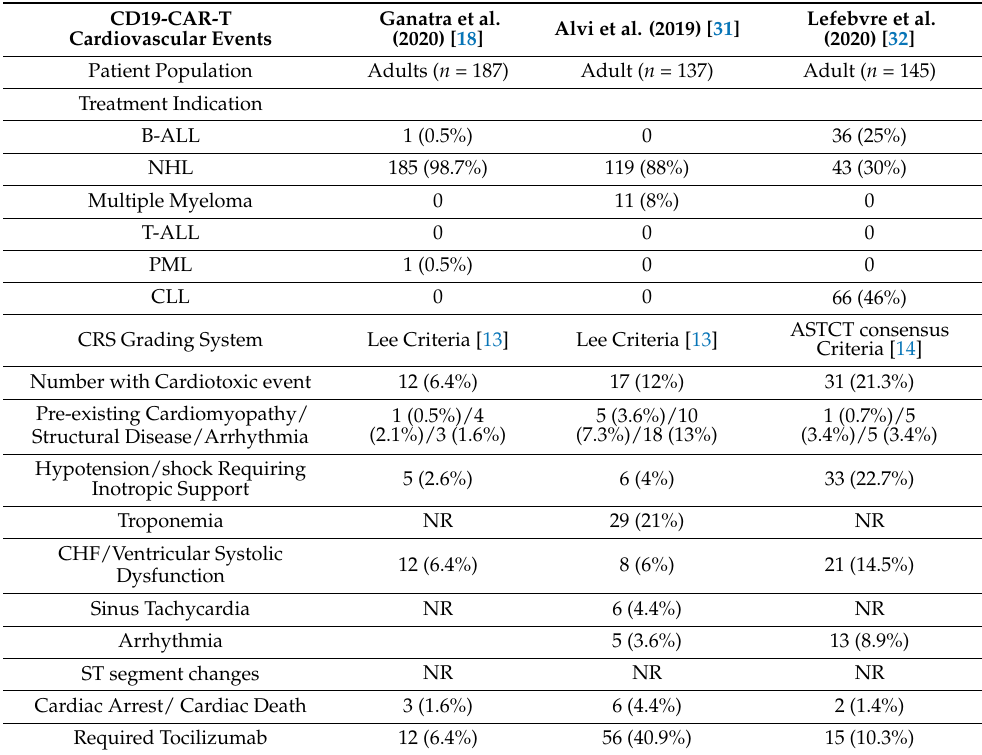
Table 6. Summary of cardiotoxicity in retrospective adult